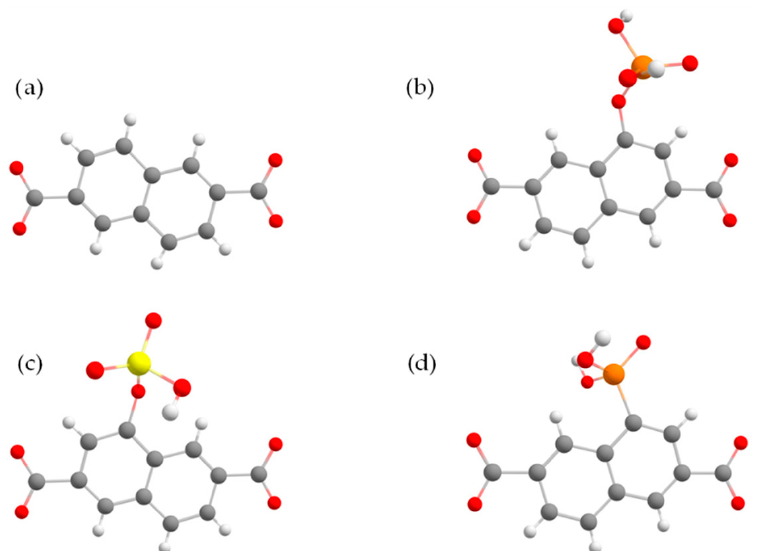
Figure 1. The functionalized linker of IRMOF-8 considered in the GCMC simulations; the original IRMOF-8 linker ( a ), the -OPO3H2 ( b ), -OSO3H ( c ), and -PO3H2 ( d ) functionalized linker. Carbon, hydrogen, oxygen, sulfur, and phosphorus atoms are depicted as gray, white, red, yellow, and orange spheres, respectively.